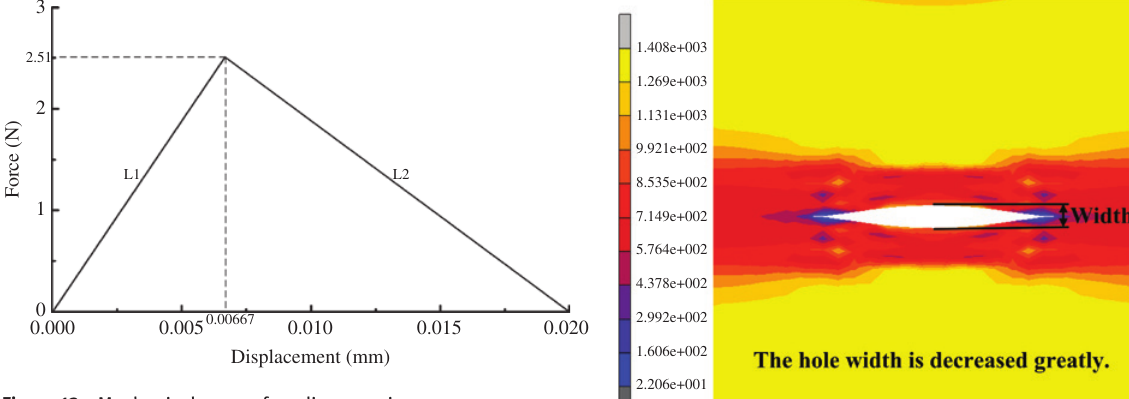
Figure 13: Mechanical curve of nonlinear